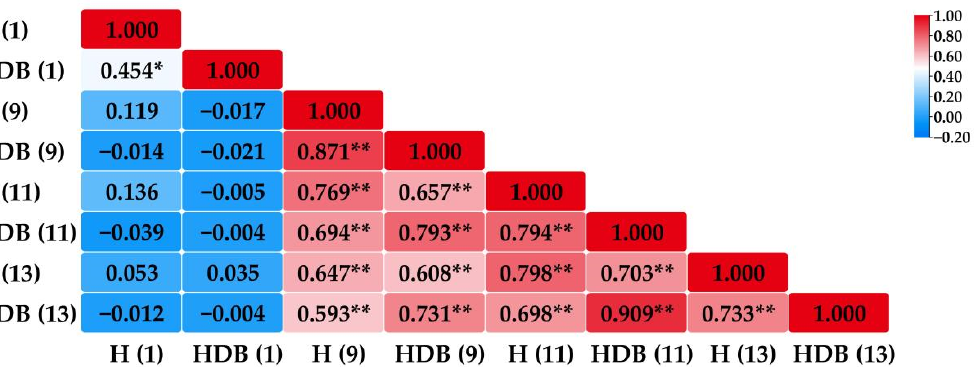
Figure 2. Correlation analysis of the growth characteristics of C. fargesii clones at 1, 9, 11 and 13 years. H, height; DBH, diameter. The numbers in brackets indicate the age of the tree. * Represents correlation is significant at the 0.05 level, and ** represents correlation is significant at the 0.01 level.